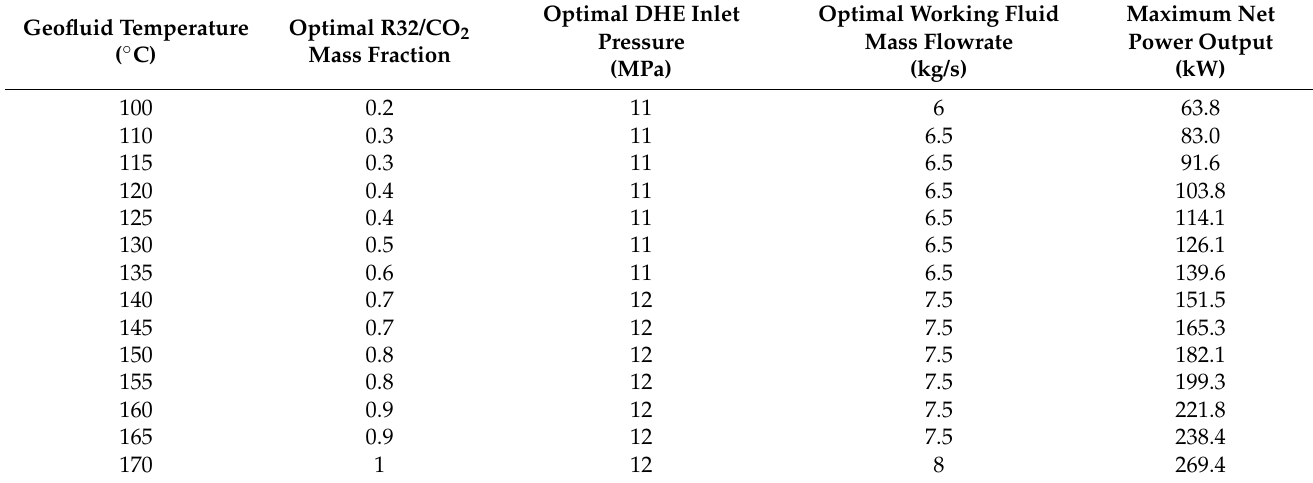
Table 4. Optimal net power outputs of the power cycle using different mixture working